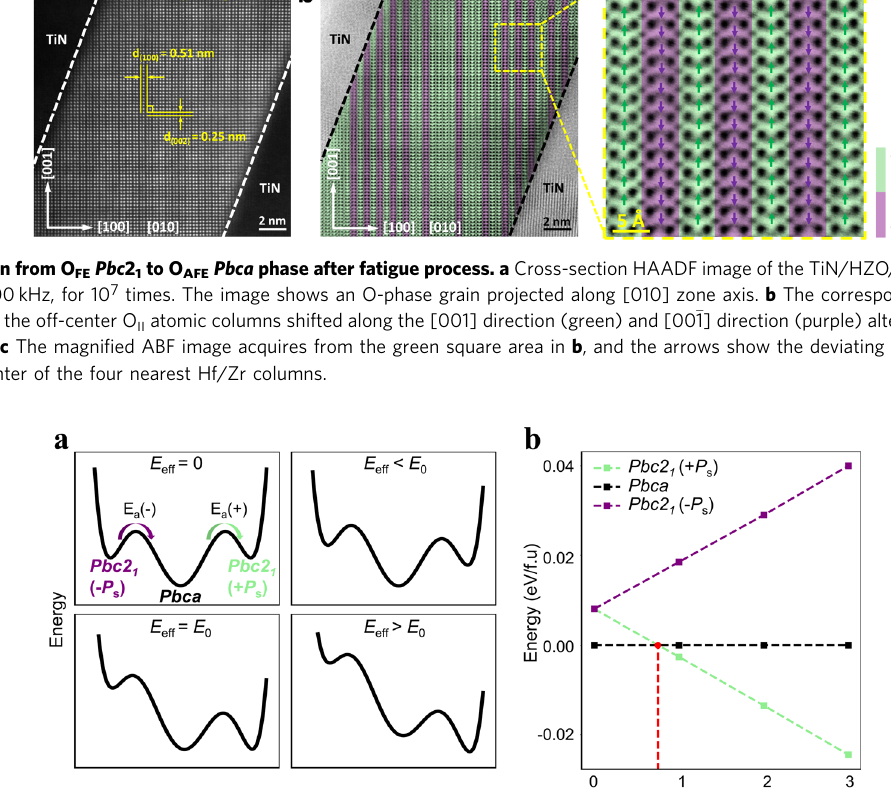
Table 1 Effective fi eld strength ( E eff ) across the O FE layer when the interfacial T-phase layer is present at V a of 3, 4, and 5.5 V. T-phase thickness (nm) O FE -phase thickness (nm) E eff (MV/cm) at V